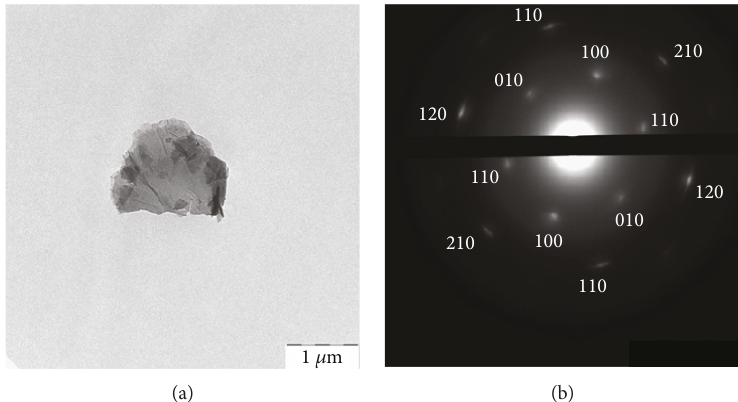
Figure 6: TEM and electron di ff raction data for a single particle of ZnO produced via the annealing process in the Al-0 fi lm.